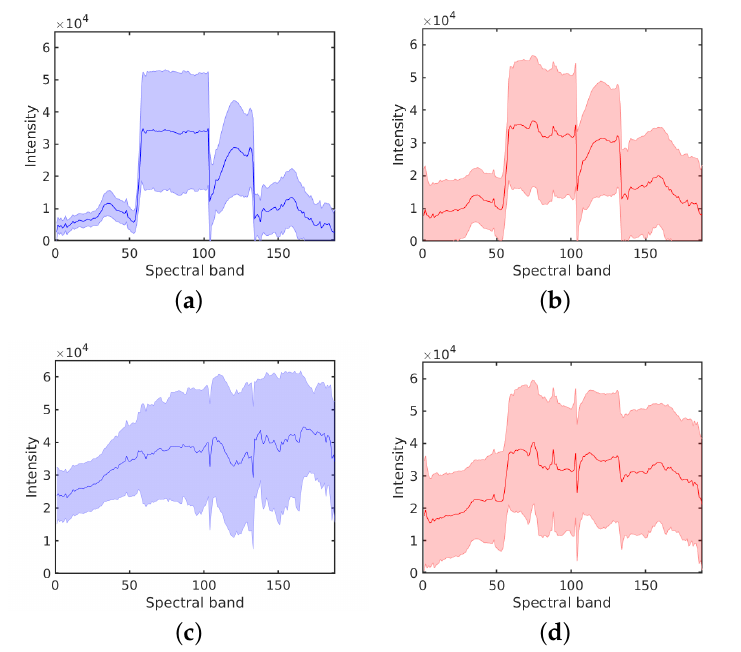
Figure 5. Estimated spectral signatures from the labeled data for two classes from HYDICE Urban , without label noise (left) and with label noise ρ = 0.5 (right). The solid line shows the average spectral signature and the shaded region denotes the standard deviation. ( a ) Class 1 with ρ = 0; ( b ) Class 1 with ρ = 0.5; ( c ) Class 5 with ρ = 0; ( d ) Class 5 with ρ = 0.5.